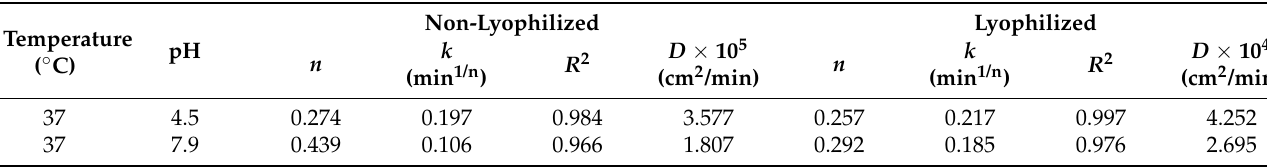
Table 7. Kinetic parameters of biochanin A release from poly( N -isopropylacrylamide-co-acrylic acid), p(NIPAM-co-AA), non-lyophilized and lyophilized, at pH values of 4.5 and 7.9 and at 37 ◦